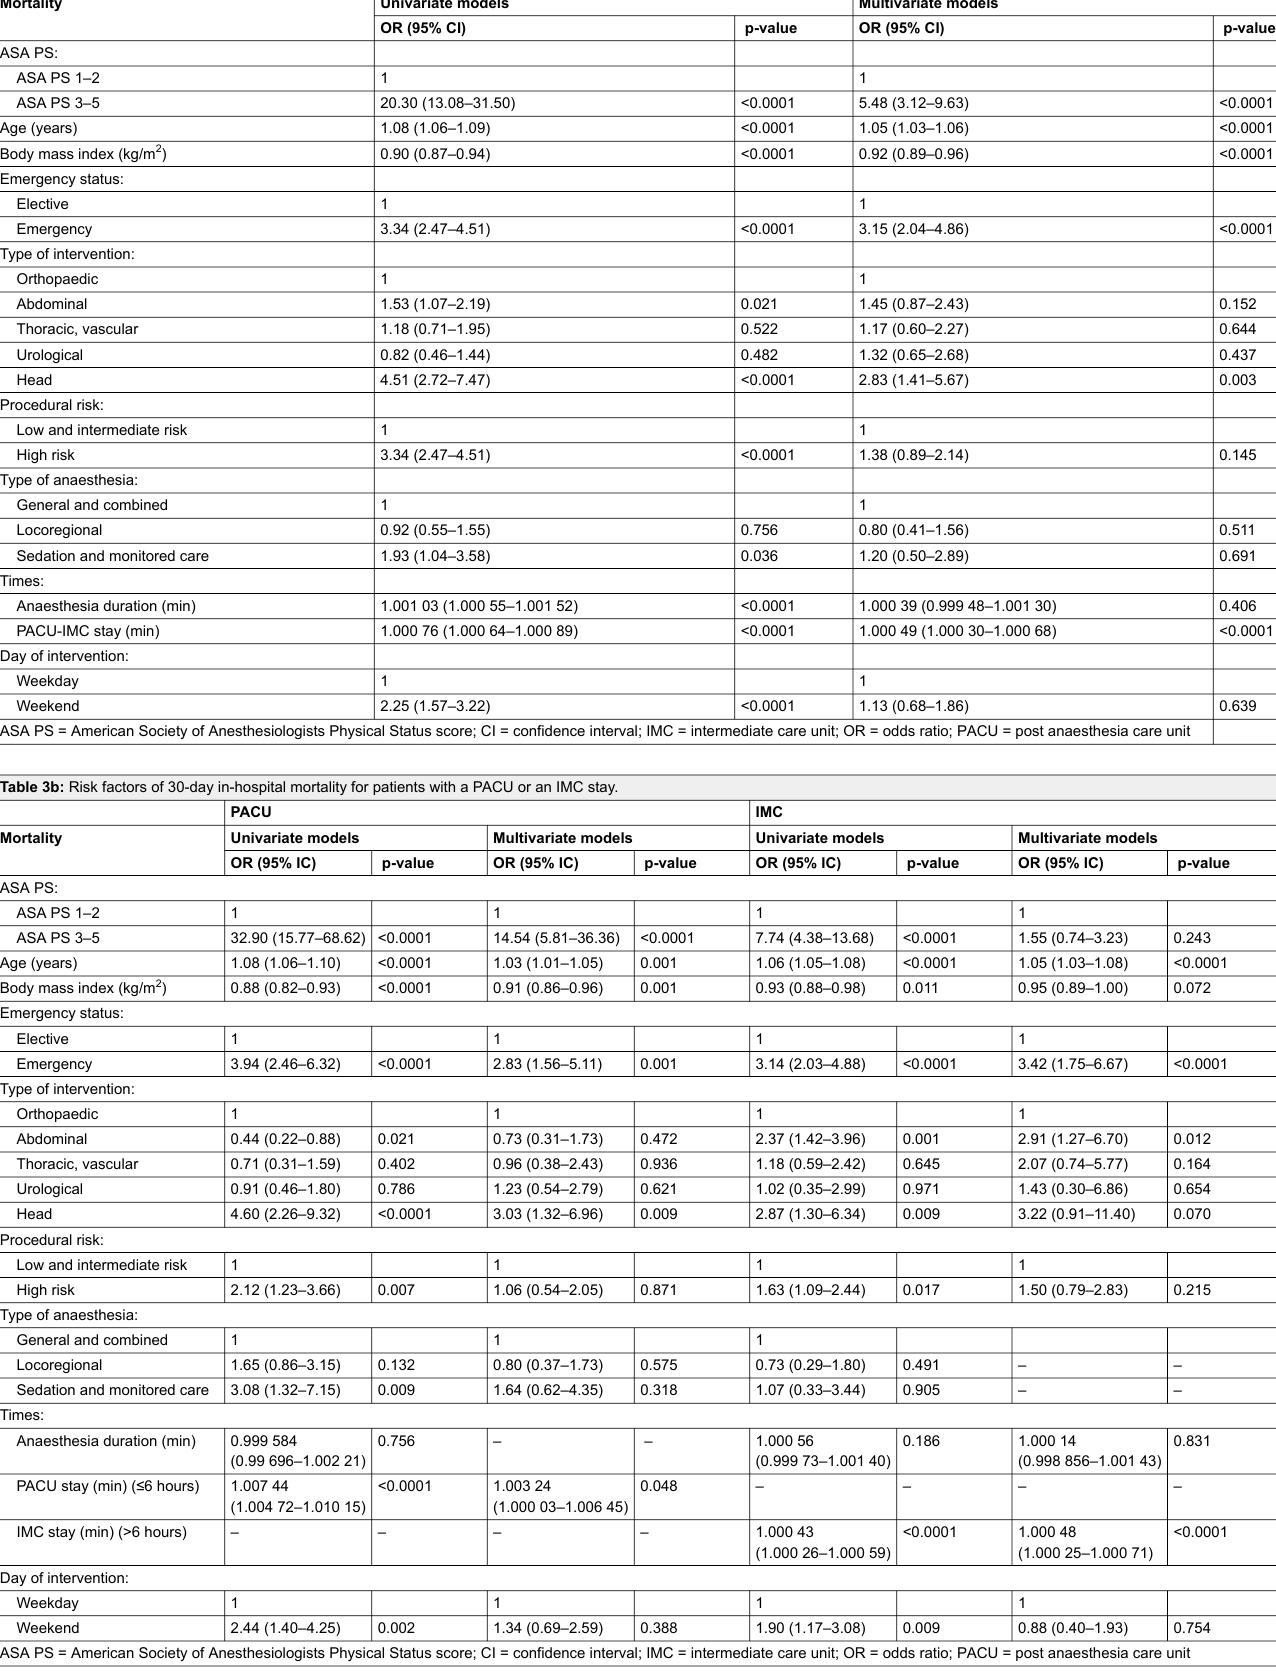
Table 3a: Risk factors of 30-day in-hospital mortality for all included patients. Univariate models Multivariate modelsMortality OR (95% CI) p-value OR (95% CI) p-value